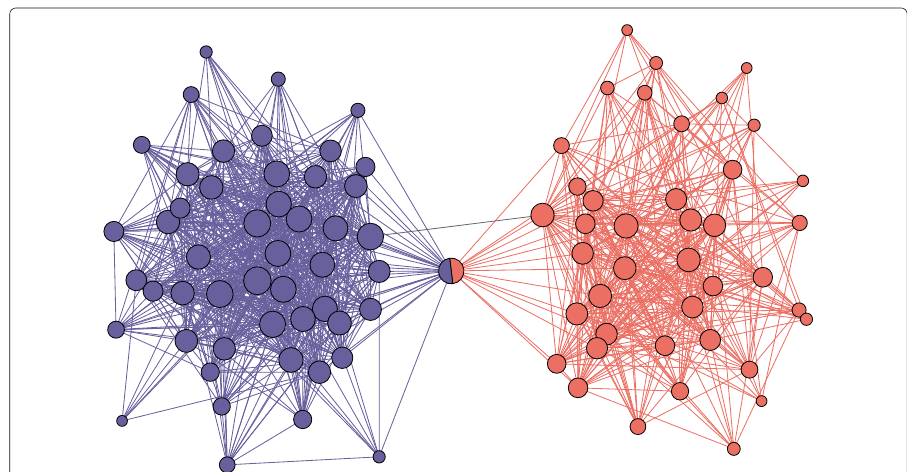
Fig. 7 A real example of a pair of overlapped communities detected by PCMA. The overlap is a single vertex colored half purple and half red. The outbound edges from the left (right) community to the right (left) are all through the overlapped vertex (category E 1), except for one edge that interconnects the two communities directly (category E 2). Since an E 2 outbound edge of a community is also an E 2 outbound edge of the corresponding neighbor community, we adopt a simplified term that the edge is an E 2 edge of the overlap.